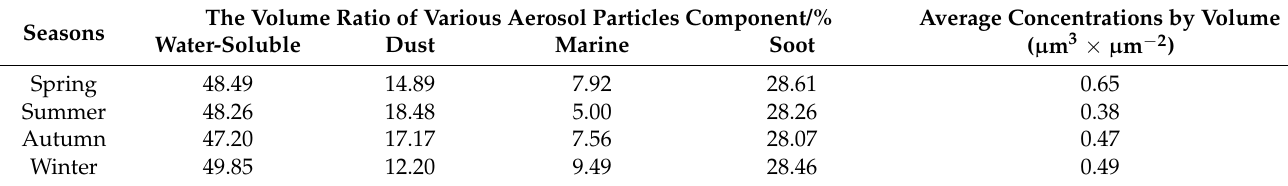
Figure 3. ( a ) The statistical distribution of AOD percentages and ( b ) average volume size distributions of particulates in different seasons. Table 3. The percentages and average concentrations of aerosol particles by volume in different seasons from 2017 to 2019 over the PRD.